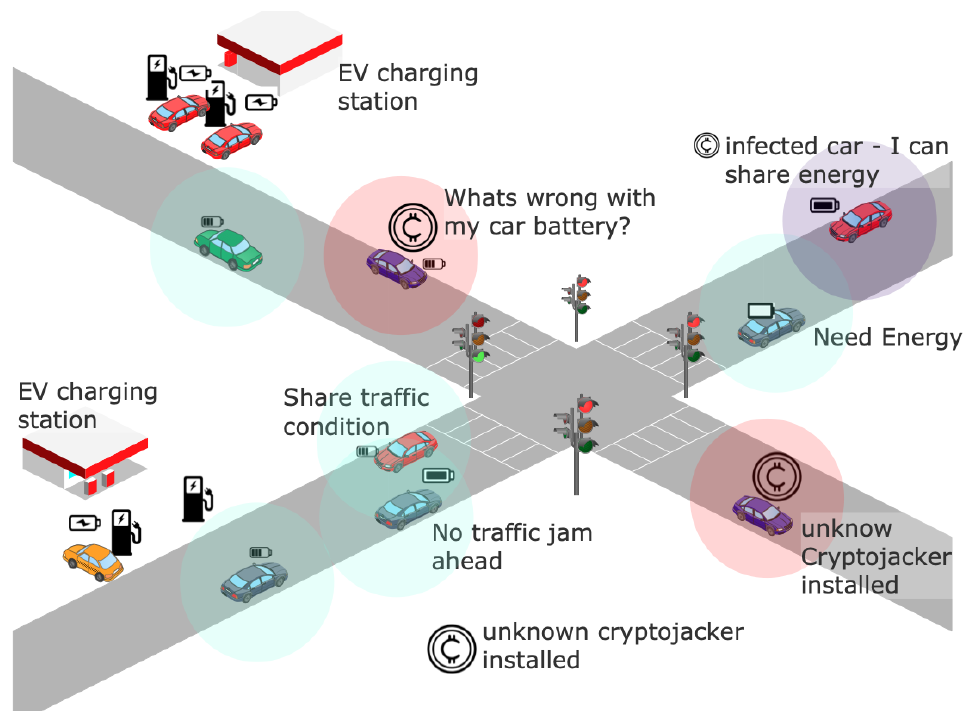
Figure 1. Road network showing cryptojacking infected